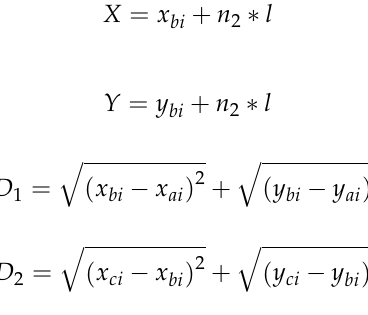
Figure 5. Road surface node composition.